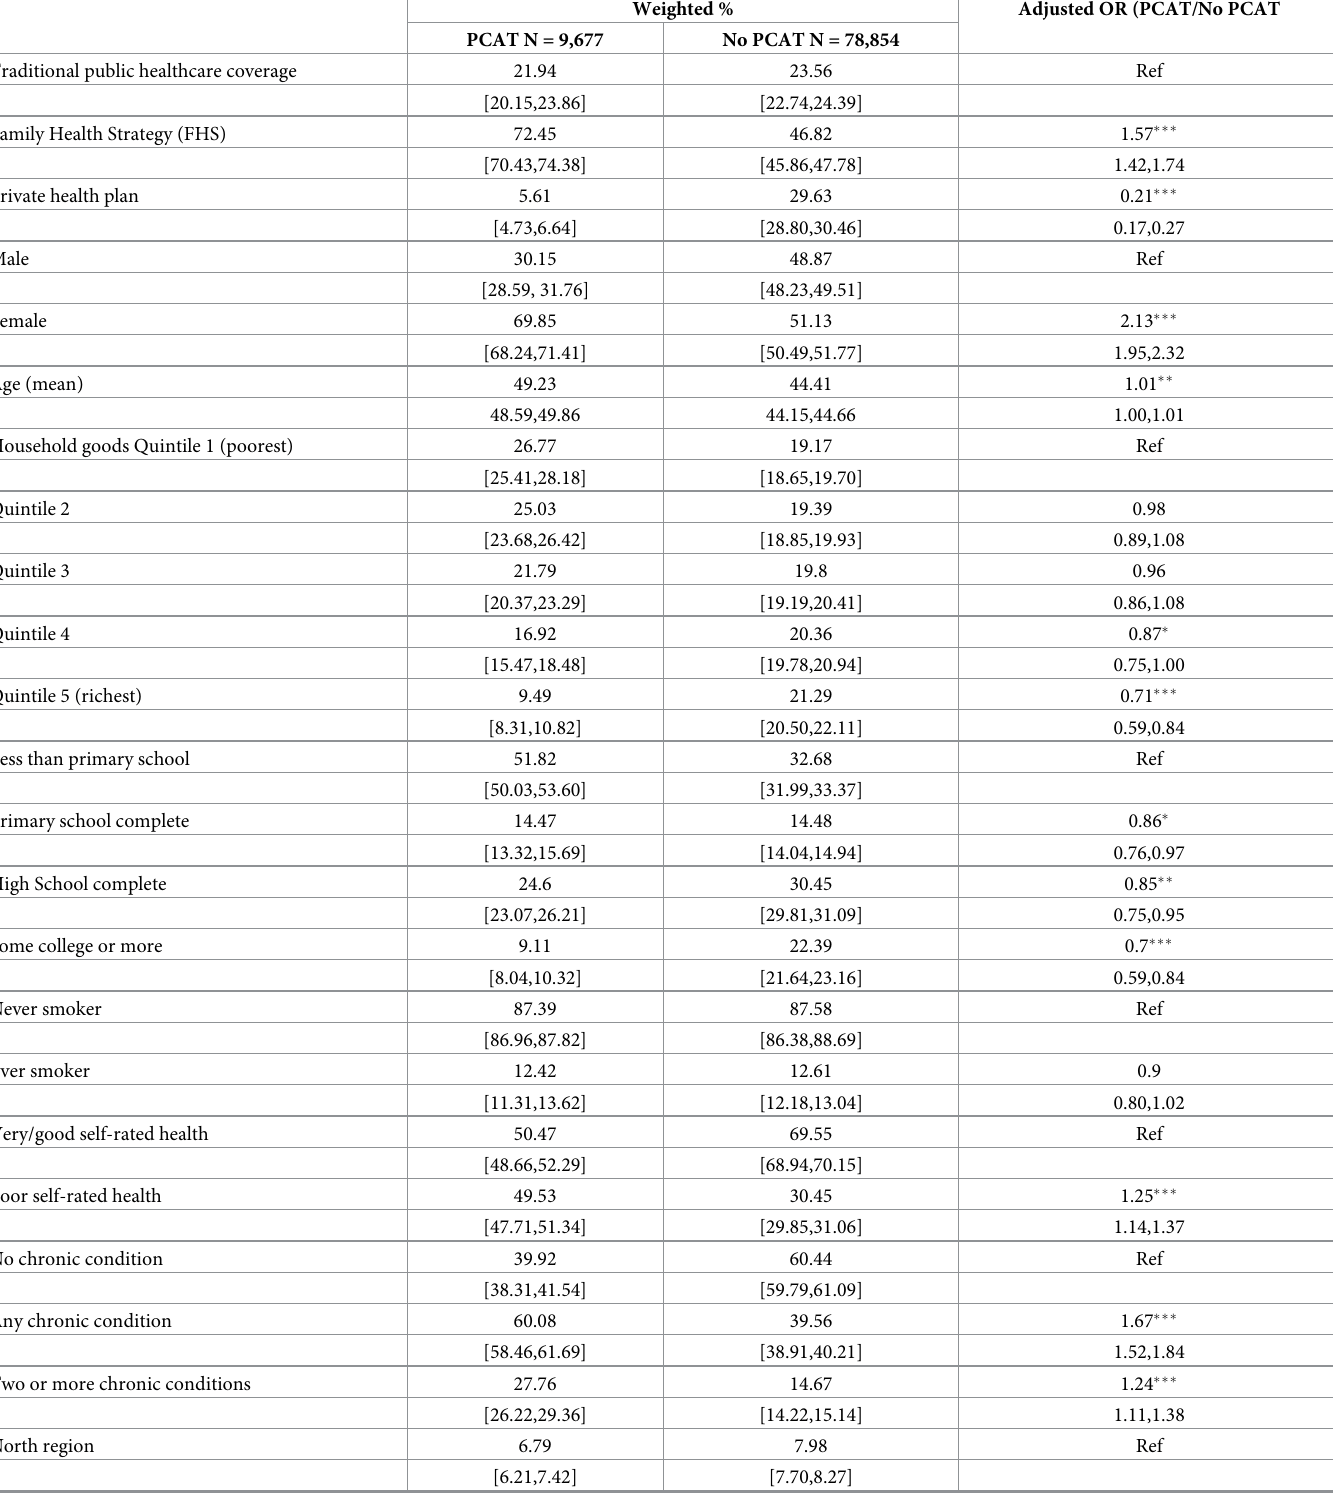
Table 4. Comparison of characteristics of respondents selected and not selected for PCAT